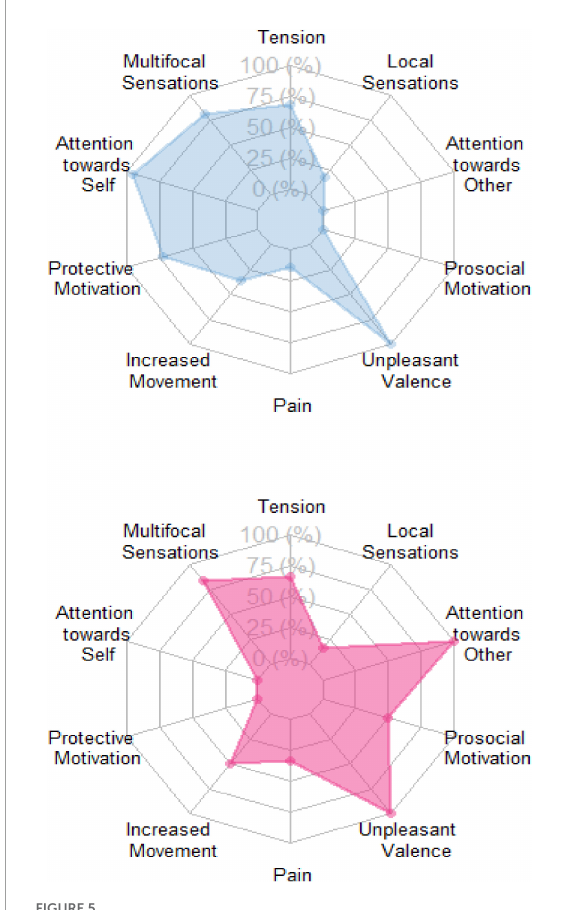
FIGURE5 Quantitative analysis of the experiential structures of empathy for pain. The figures show the frequency (%) of participants in the self-centered empathy for pain (blue) and other-centered empathy for pain (pink) groups experiencing each phenomenological